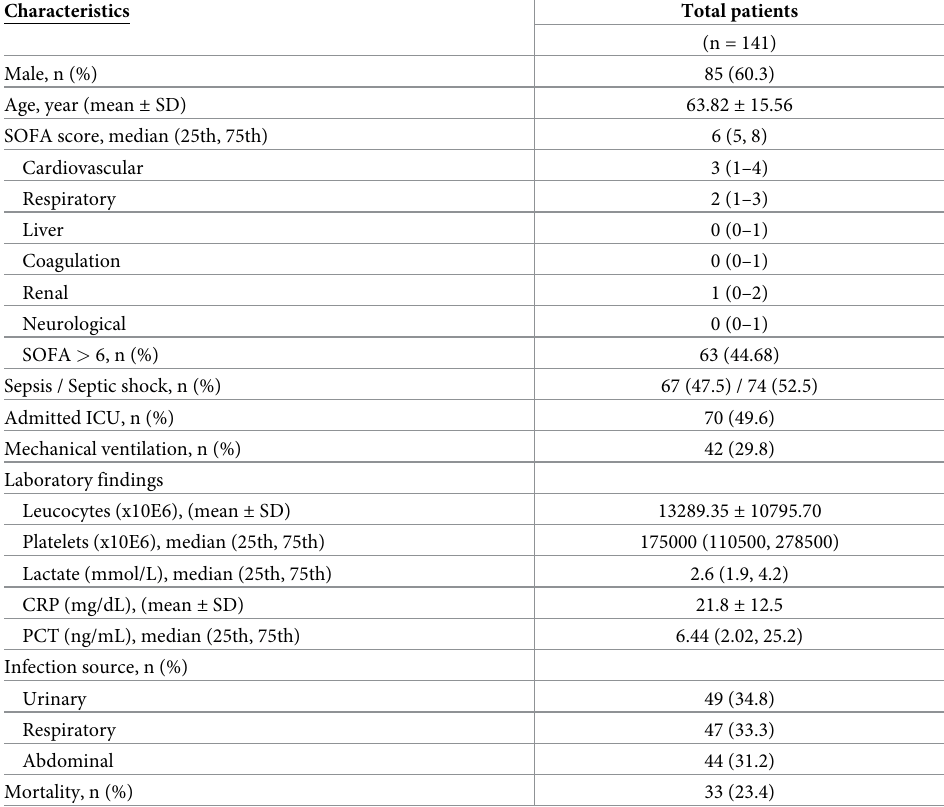
Table 1. Characteristics of the study population.